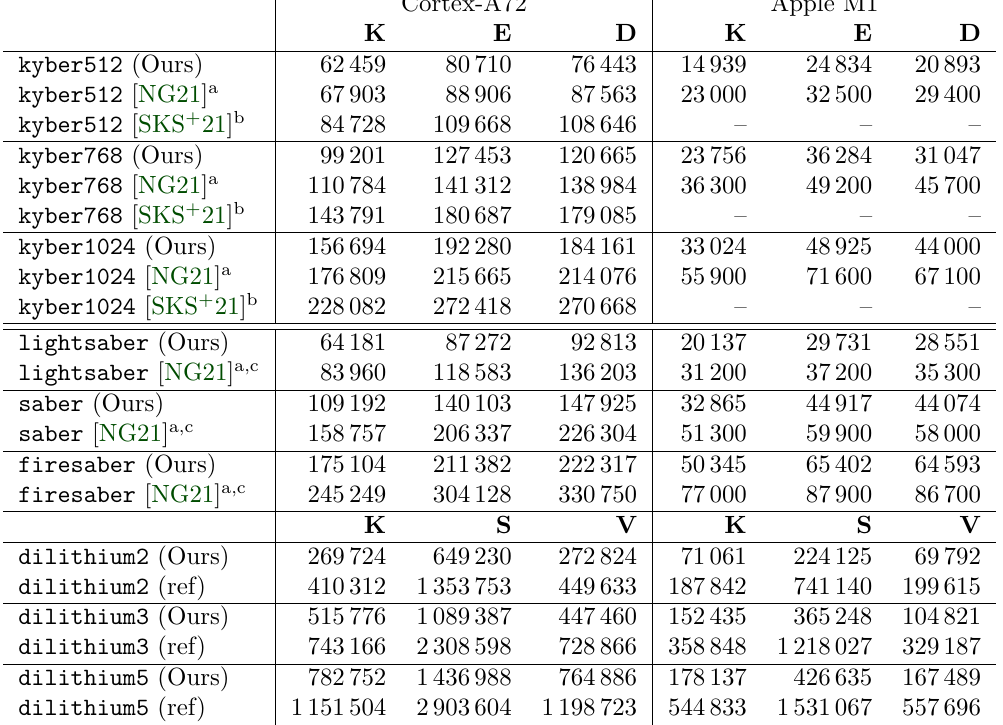
Table 6: Performance results for the full schemes kyber768 , saber , and dilithium3 on Cortex-A72 and Apple M1. On Cortex-A72, we report the median cycle count of 10 000 executions for Kyber and Saber, and 100 000 executions for Dilithium. On Apple M1, we report the average cycle count of 10 000 executions for Kyber and Saber, and 1 000 000 executions for Dilithium. For Dilithium, we sign 59-byte